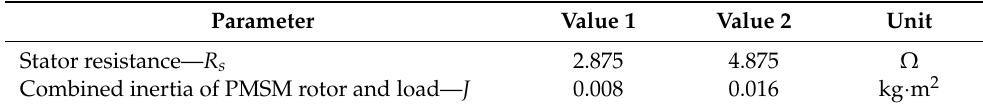
Table 2. PMSM variation parameters—variable structure